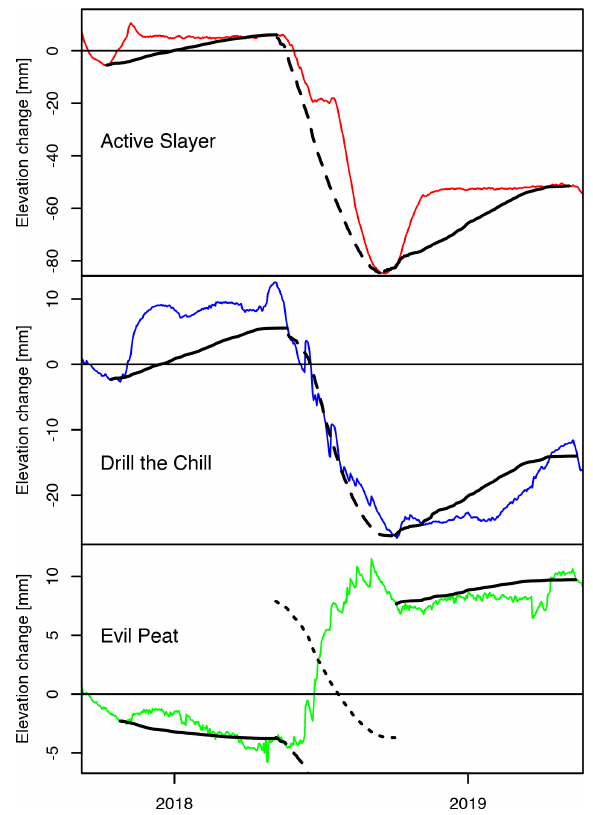
Figure 7. Visual comparison of observed elevation change (color) with predictions (black) based on the Stefan equation and ground temperature. Solid black lines represent freezing seasons and dashed lines thawing seasons. The dotted line for site Evil Peat has been shifted upwards for clarity, illustrating that the observed thaw- ing season was accompanied by surface heave, whereas the Stefan model predicts subsidence. Predictions are scaled and shifted to co- incide with observations at the start and end of the freezing and thawing seasons and, therefore, can only be used to visually assess how well they resemble the temporal pattern of elevation but not seasonal